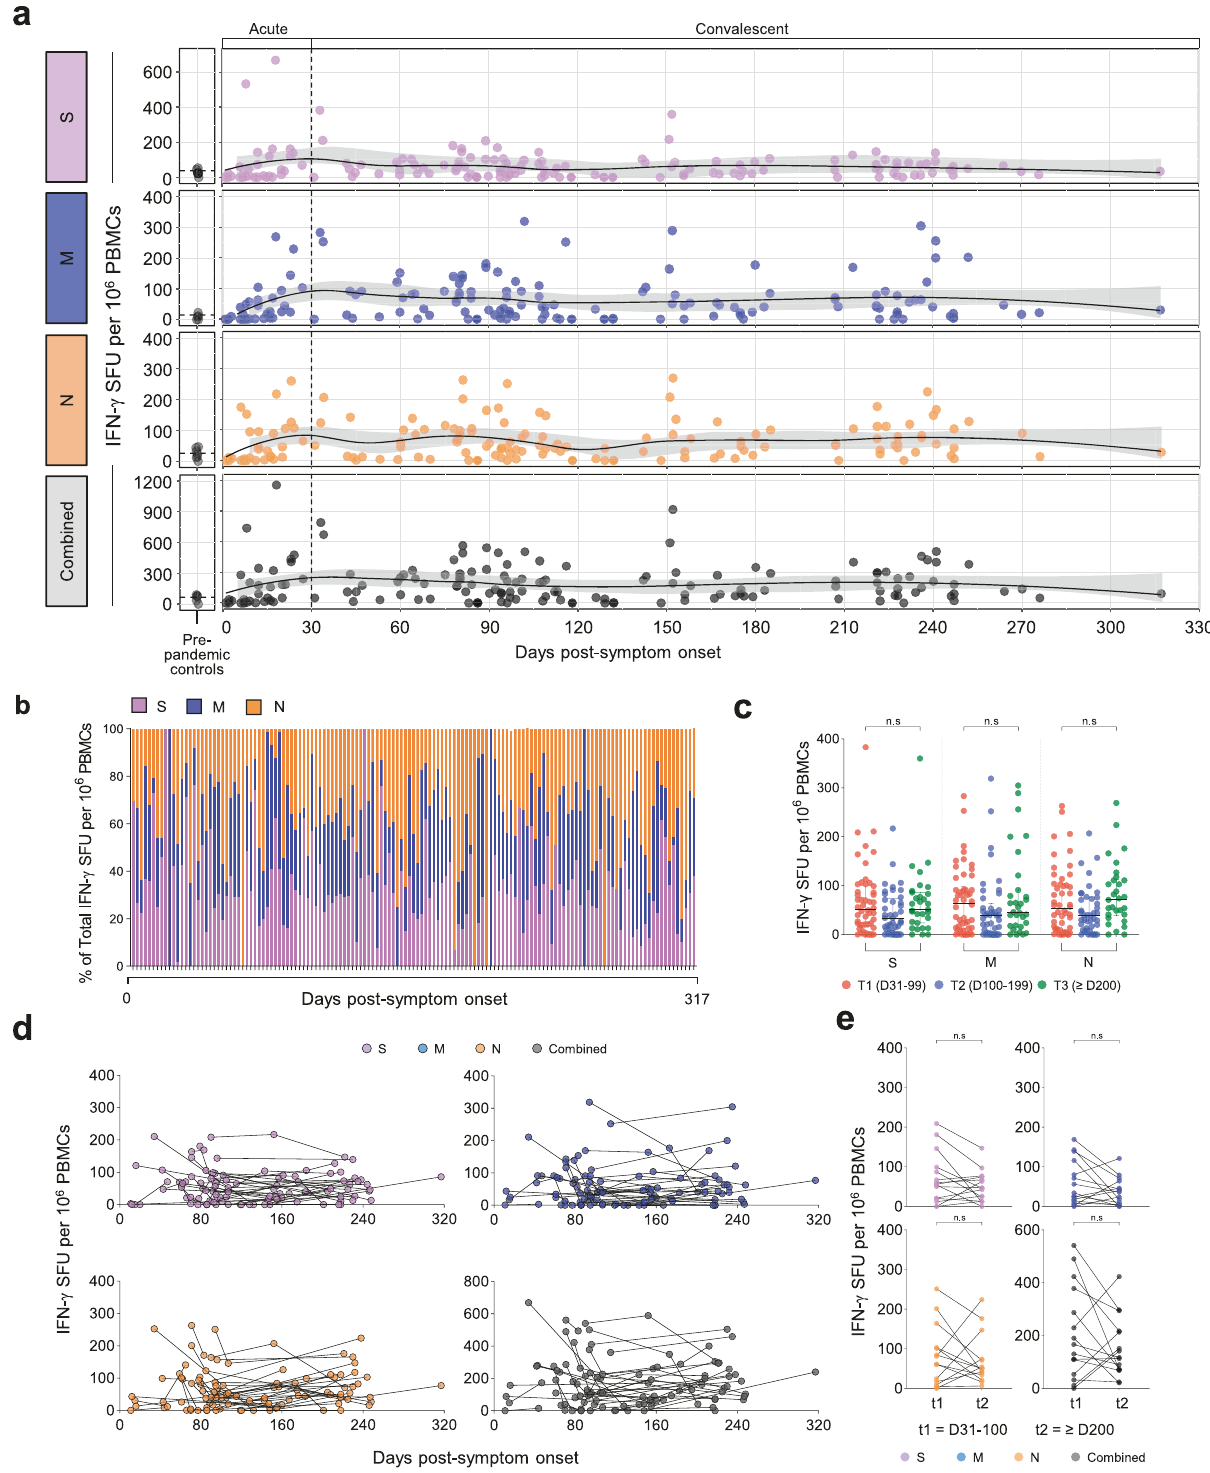
Fig. 1 SARS-CoV-2-speci fi c IFN- γ responses over 10 months post-infection. PBMC samples ( n = 159) from individuals with SARS-CoV-2 infection ( n = 87) and pre-pandemic PBMC samples ( n = 8) from healthy donors ( n = 8) were stimulated with OLPs of S, M, or N (1 μ g/mL) for 24 h and the spot- forming units of IFN- γ -secreting cells examined by ELISpot. a Scatter plots showing the relationship between DPSO and IFN- γ responses. The black line is a LOESS smooth nonparametric function, and the gray shading represents the 95% con fi dence interval. b The composition of S-, M-, or N-speci fi c IFN- γ responses among the total IFN- γ responses in each individual. c IFN- γ responses were compared between T1 ( n = 49, 31 – 99 DPSO), T2 ( n = 41, 100 – 199 DPSO), and T3 ( n = 31, ≥ 200 DPSO). Data are presented as median and interquartile range (IQR). d, e IFN- γ responses were analyzed in longitudinally tracked samples ( n = 103) from 39 individuals. d Scatter plots showing the relationship between DPSO and IFN- γ responses. e IFN- γ responses were compared between paired samples at two-time points ( n = 15; t1, 31 – 100 DPSO; t2, ≥ 200 DPSO). Statistical analysis was performed using the two-sided Kruskal – Wallis test with Dunns ’ multiple comparisons test ( c ) or the Wilcoxon signed-rank test ( e ). n.s, not signi fi cant.